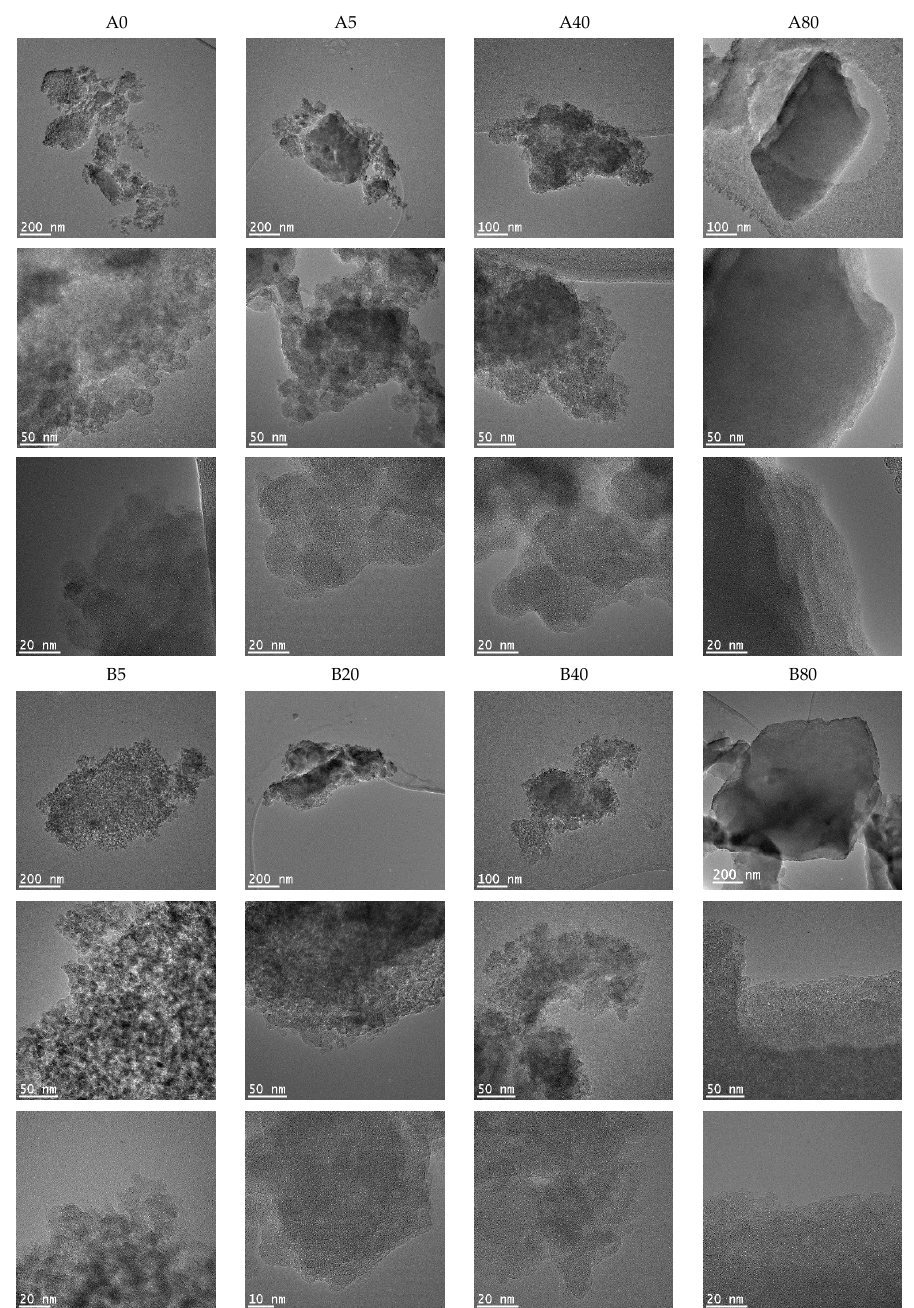
Figure 4. TEM images of the hybrid silica xerogels, series A and B, obtained with different methyl substituent content (series A and series B labels represent the pH = 2.0 and pH = 4.5).